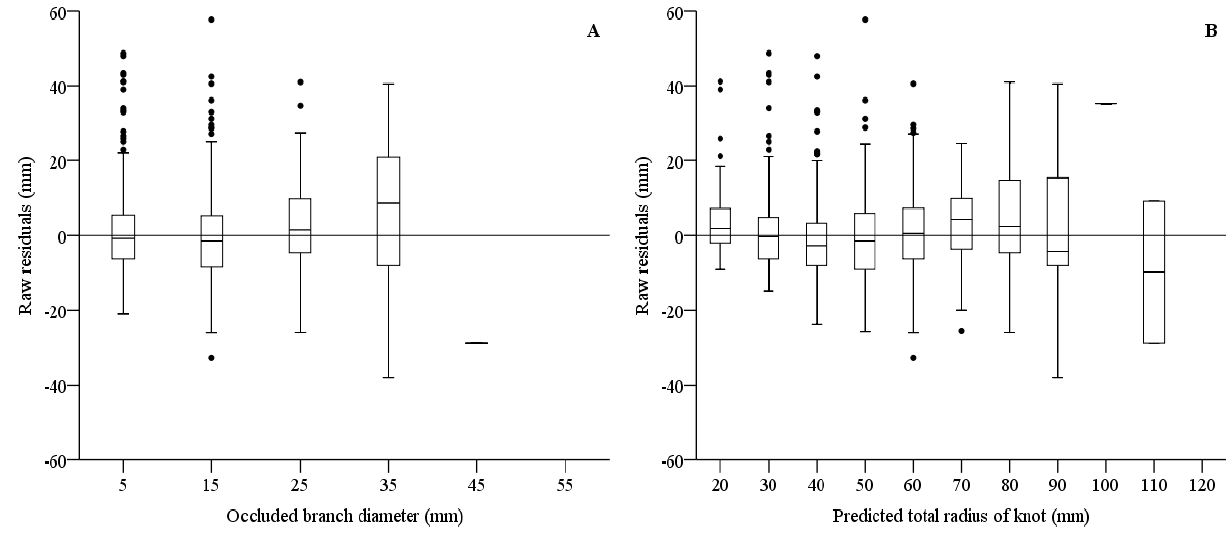
Figure 4. Raw residuals of the model on total radius of knot plotted against the independent ( A ) and predicted ( B ) variables. The edges of the box are 25th and 75th percentiles; the vertical lines are drawn from the box to the most extreme point within 1.5 interquartile ranges; the transverse lines in boxes connect the